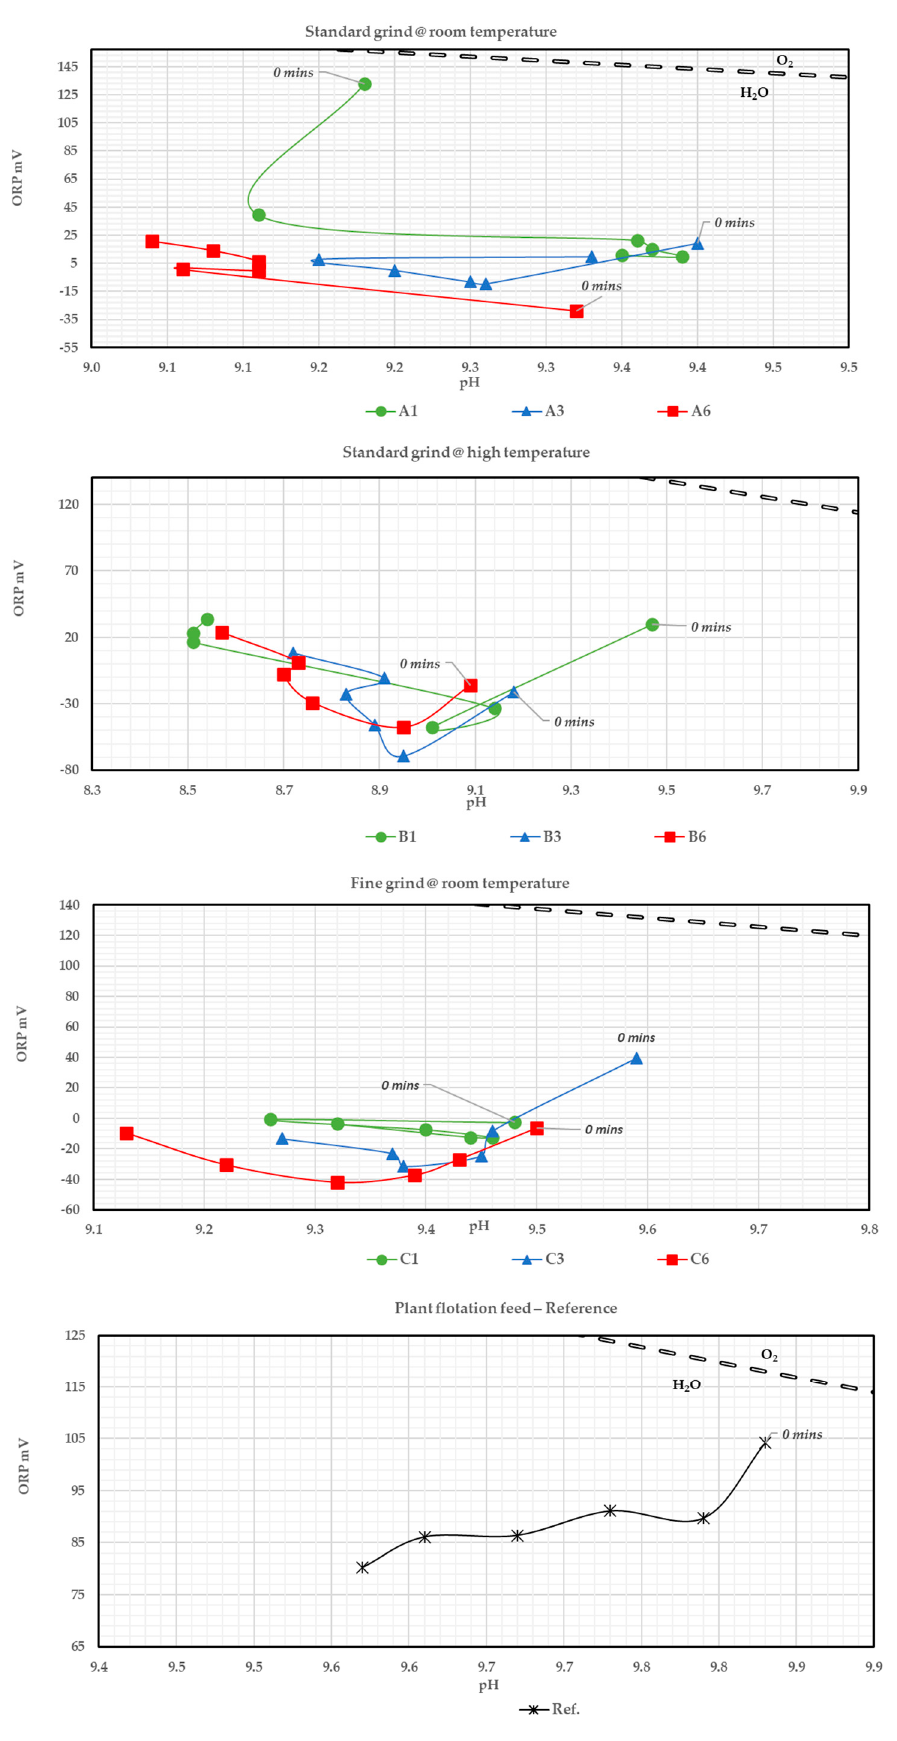
Figure 5. Effect of dissolution loop and dissolution time on pH vs.